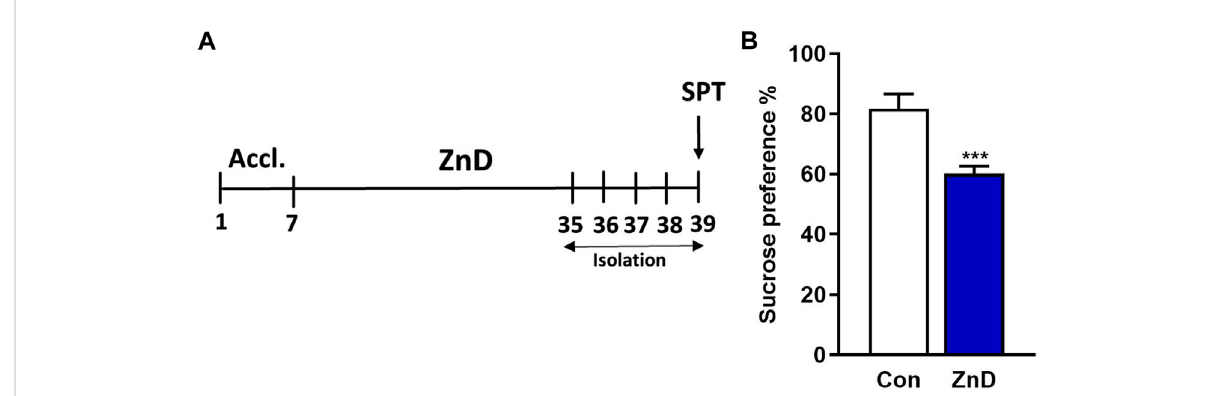
FIGURE 1 Effectsoflow-ZndietintheSPTinmice. (A) Experimentalschedule. (B) SPT.Allvaluesareexpressedasmean±SEM.Thedatawereanalyzedby Student ’ s t-test; N = 10, *** p <